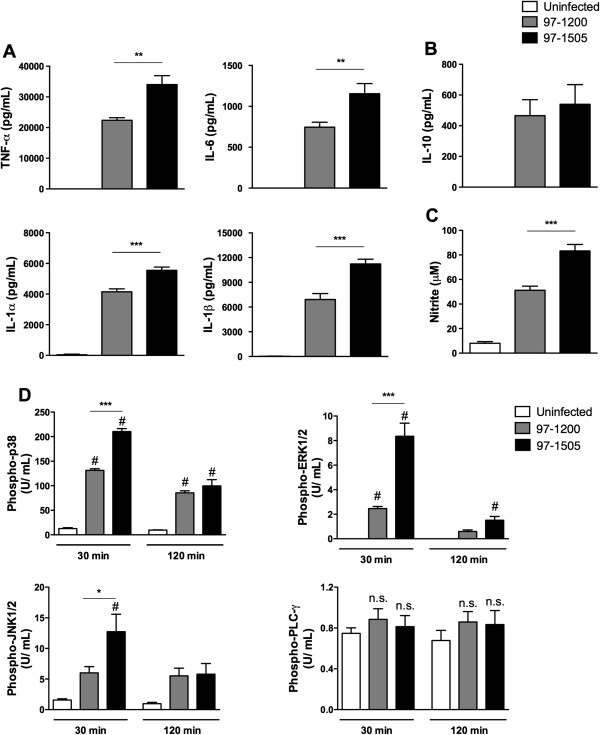
PLC-expressing Mycobacterium tuberculosis more efficiently stimulates the cell activation, production of proinflammatory cytokines and NO2 in alveolar macrophages. Production of (A) the proinflammatory cytokines TNF-α, IL-1α, IL-1β, and IL6; (B) IL-10, determined by ELISA, and (C) NO, determined by Greiss reaction. (D) Quantification of phosphorylated p38, ERK1/2, JNK1/2, and PLC-γ determined by CBA (Cytometric Bead Array), and expressed as U/ mL. # P < 0.0001 for uninfected cells vs. infected cells (97-1505 or 97-1200); ***P < 0.0001; *P < 0.05 (one-way ANOVA). Data are representative of three (A–C) and two (D) independent experiments (error bars, s.e.m.).